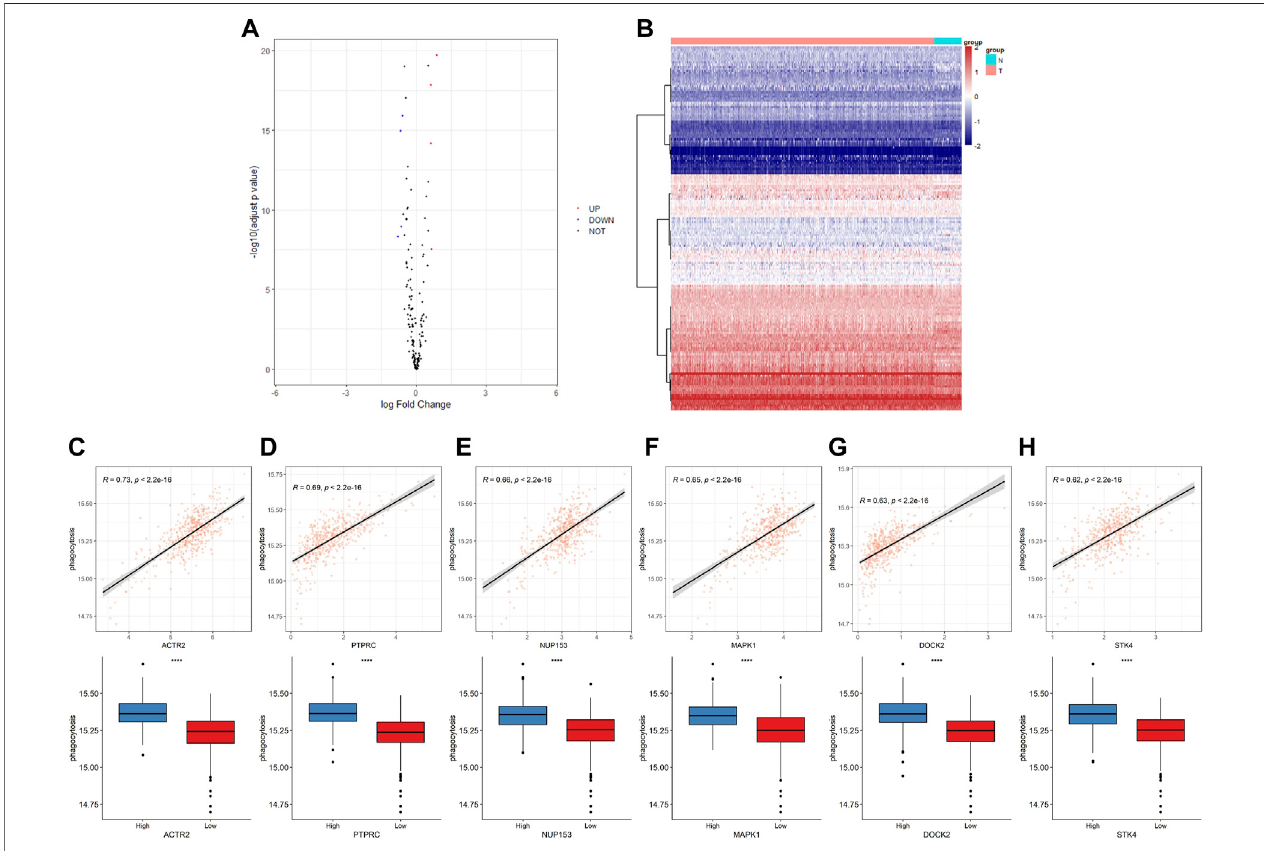
FIGURE 2 | The expression of phagocytic factors and correlation with the phagocytic enrichment score in PRAD. (A) Analysis of phagocytic factor expression differences between normal and tumor samples (left: volcano diagram, red dots indicate up-regulation, blue dots indicate down-regulation); (B) Heat maps of the phagocytic factor expression in normal and tumor samples (right: red indicates the tumor group; blue indicates the normal group); (C – H) Correlation between 6 top phagocytic factors and phagocytic enrichmentscoresin PRAD samples(upperpart); Comparison ofthephagocyticenrichmentscore between thehigh- and low- expression group of top 6 top phagocytic genes (lower